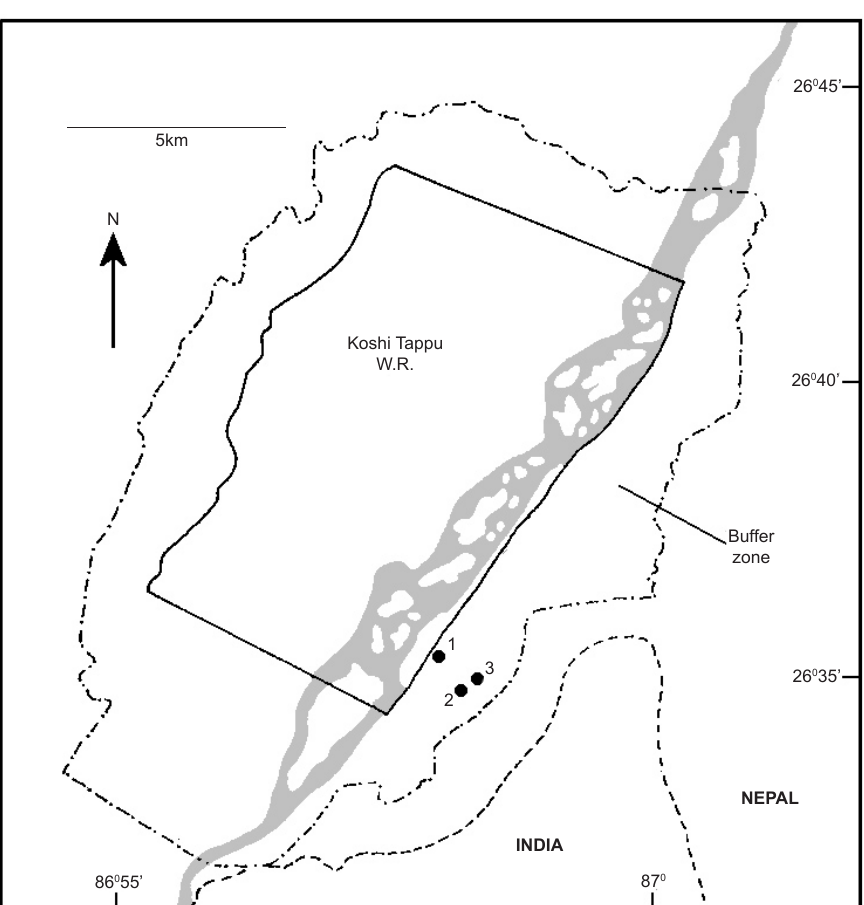
Figure 2. Koshi Tappu W.R. and buffer zone. Black dots indicate the following localities: 1 - Kusaha; 2 - Goithi Tole; 3 - Samsul